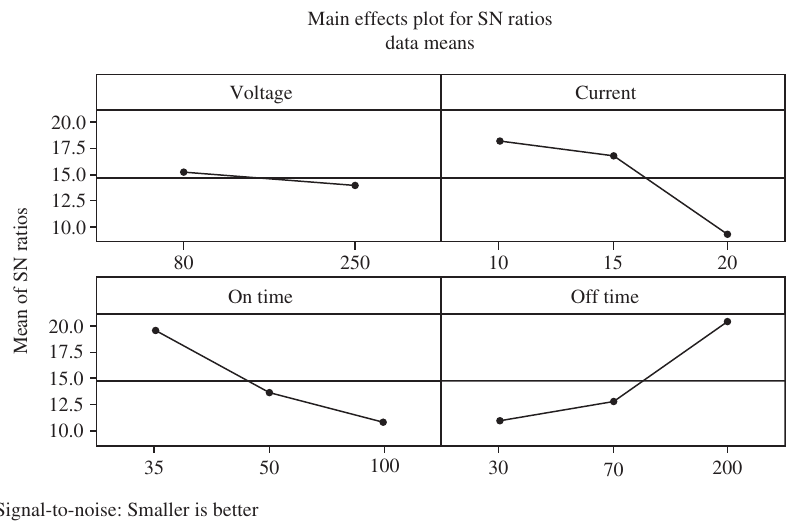
The results of ANOVA for the response functions of TWR in the machining of 2024 alloy are given in Table